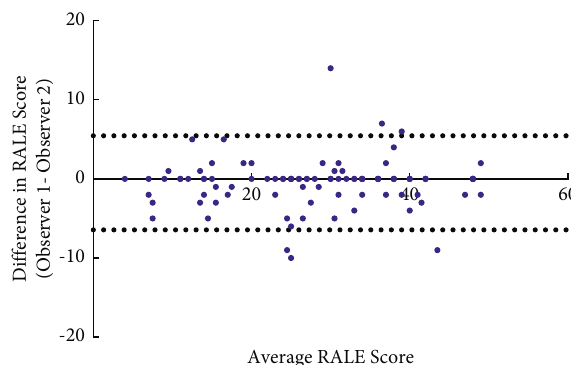
Figure 3: Bland–Altman plots showing agreement of two inde- pendent observers of RALE observers of RALE scores (bias � − 0.49, SD of bias � 3.035,